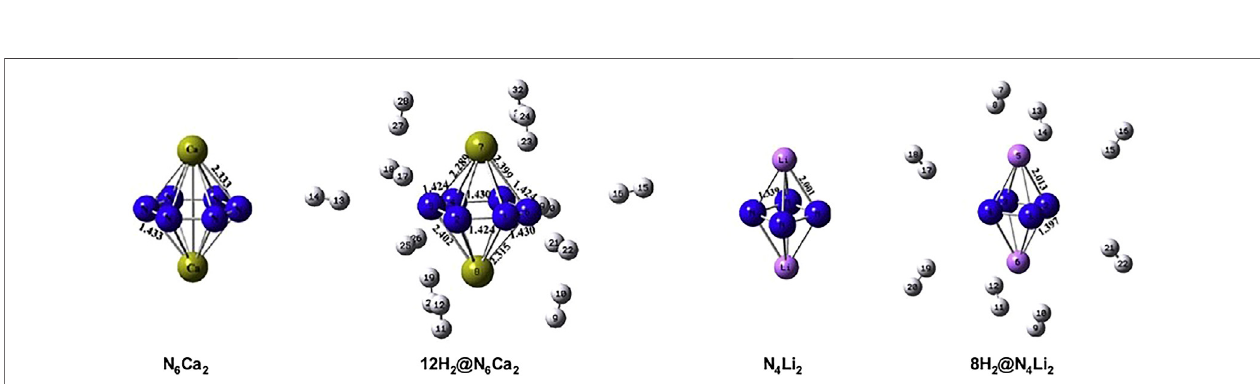
FIGURE9| Optimized geometries ofN 6 Ca 2 , N 4 Li 2 , and their respective maximum hydrogen loaded systems at B3LYP/6-31G(d)level oftheory (Reproducedfrom Duley et al., 2011 with permission from Elsevier. Copyright © 2011 Elsevier B.V.).